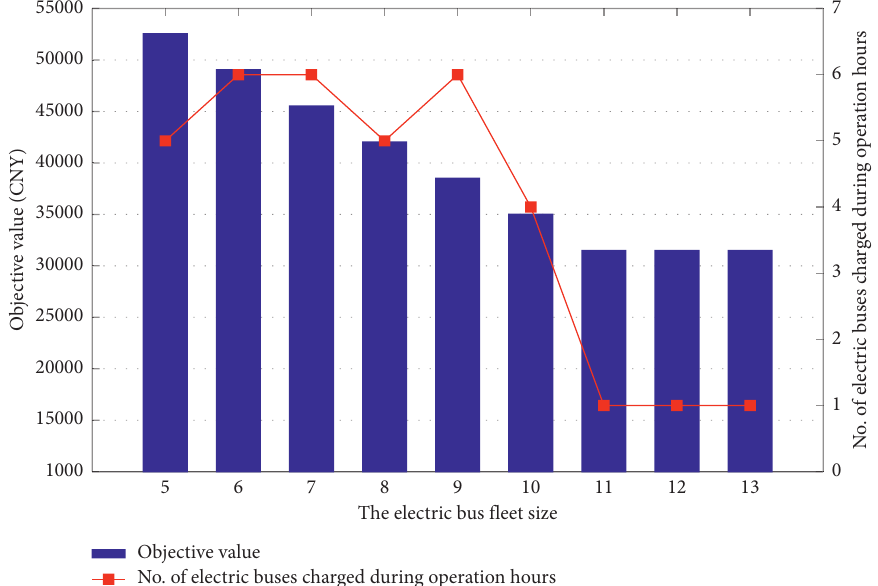
Figure 12: Effect of the fleet size on the objective value and number of buses charged during operation